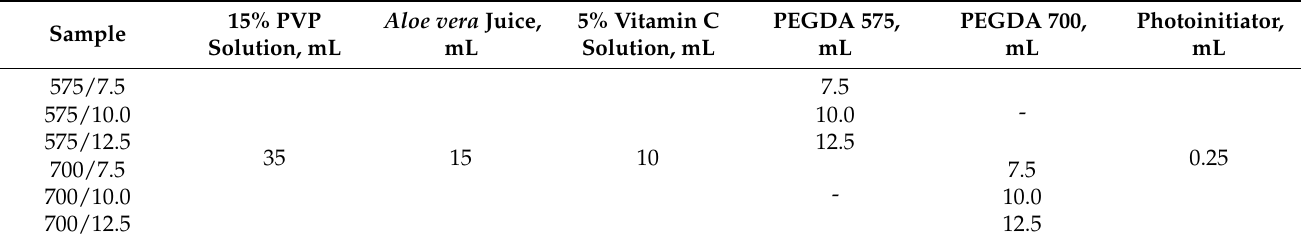
Table 1. Detailed compositions of the